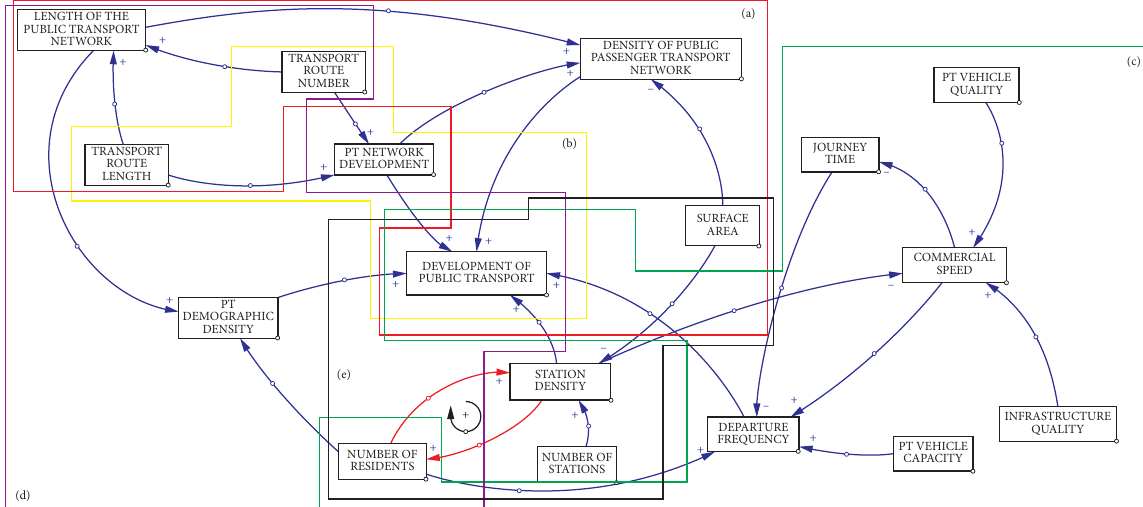
Figure 3: Structure of feedback loops (causal loop diagram) in the system of development criteria of public transport.